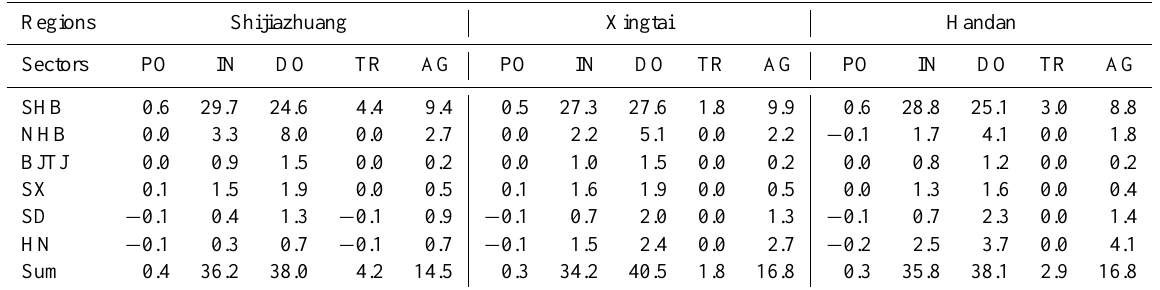
Table 5b. The average source contributions (%) to the PM 2 . 5 concentrations in Shijiazhuang, Xingtai, and Handan by source regions and sectors (for the period 14 January–28 February): Regions Shijiazhuang Xingtai